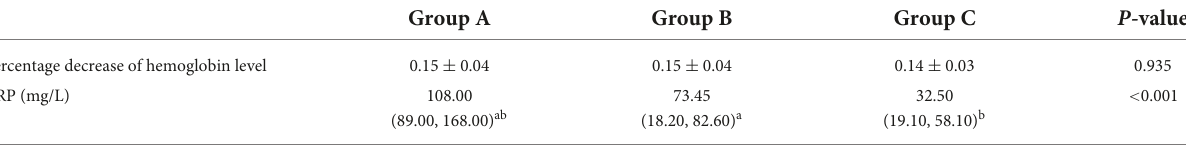
TABLE 5 Comparison of postoperative indicators among the three